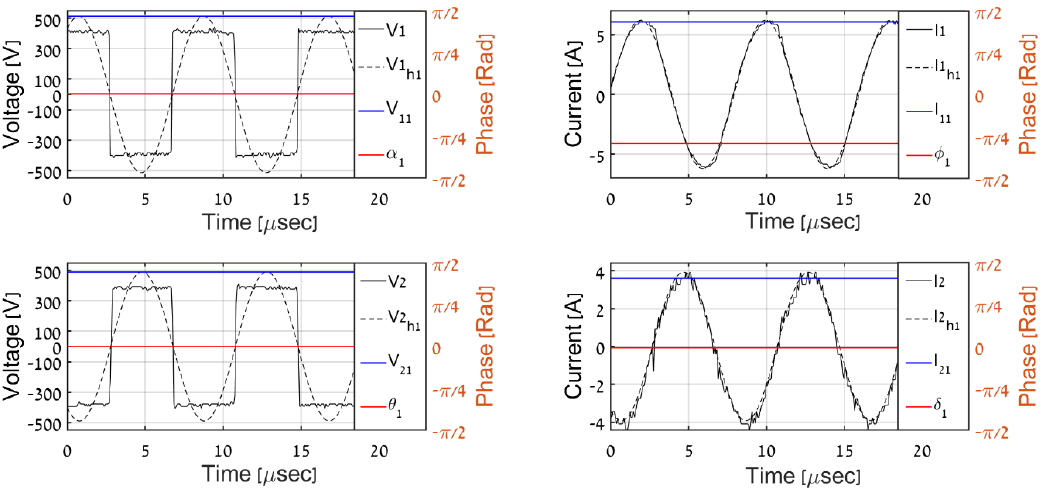
Figure 13. Experimental results, P O = 1000 W.